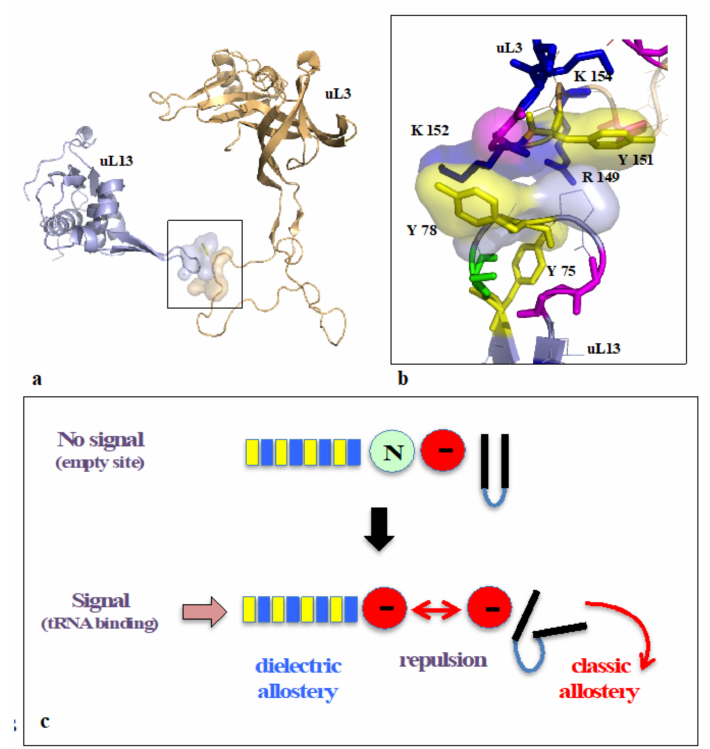
Figure 8. Aromatic amino acids in information transfer and processing. ( a , b ): global and detailed view of a “molecular synapse” in bacterial large subunit r-protein network. The conserved amino acids are represented by coloured sticks. ( c ) Possible pathways of electrostatic signalling through an array of action- π interactions (yellow rectangles = aromatic residues and blue rectangles are basic residues). The combination of diverse allosteric modules can integrate multiple stimuli. The transient change of charge of an amino acid such as a histidine induced by its electrostatic context may induce large conformational changes (“N” = neutral and “ − ” = negative